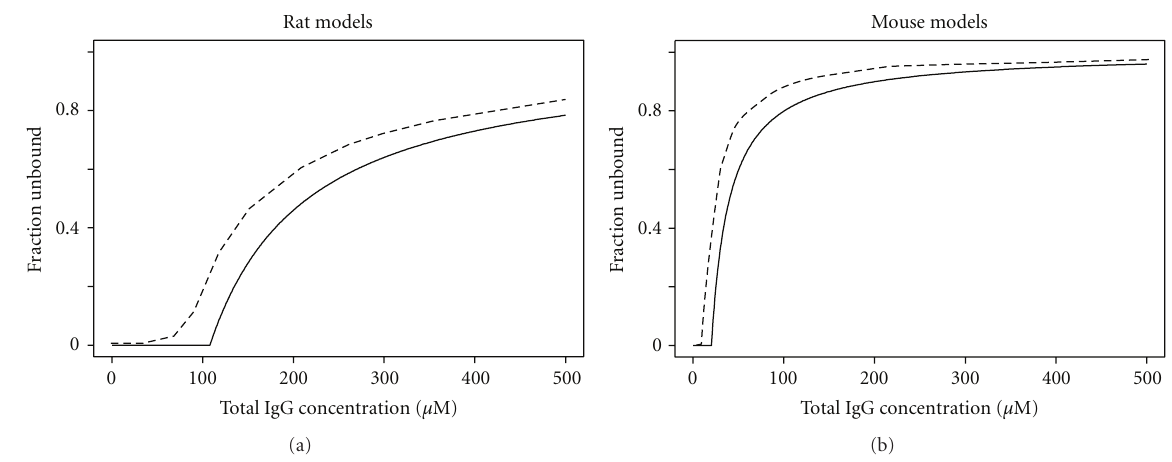
Figure 6: Relationship between f U and total peripheral IgG concentration (cuto ff models, solid lines) or total plasma IgG concentration (Hansen’s models, dashed lines). The f U values for Hansen’s models were calculated according to the published models [4]. The f U values for the cuto ff models were based on the model parameters in Table